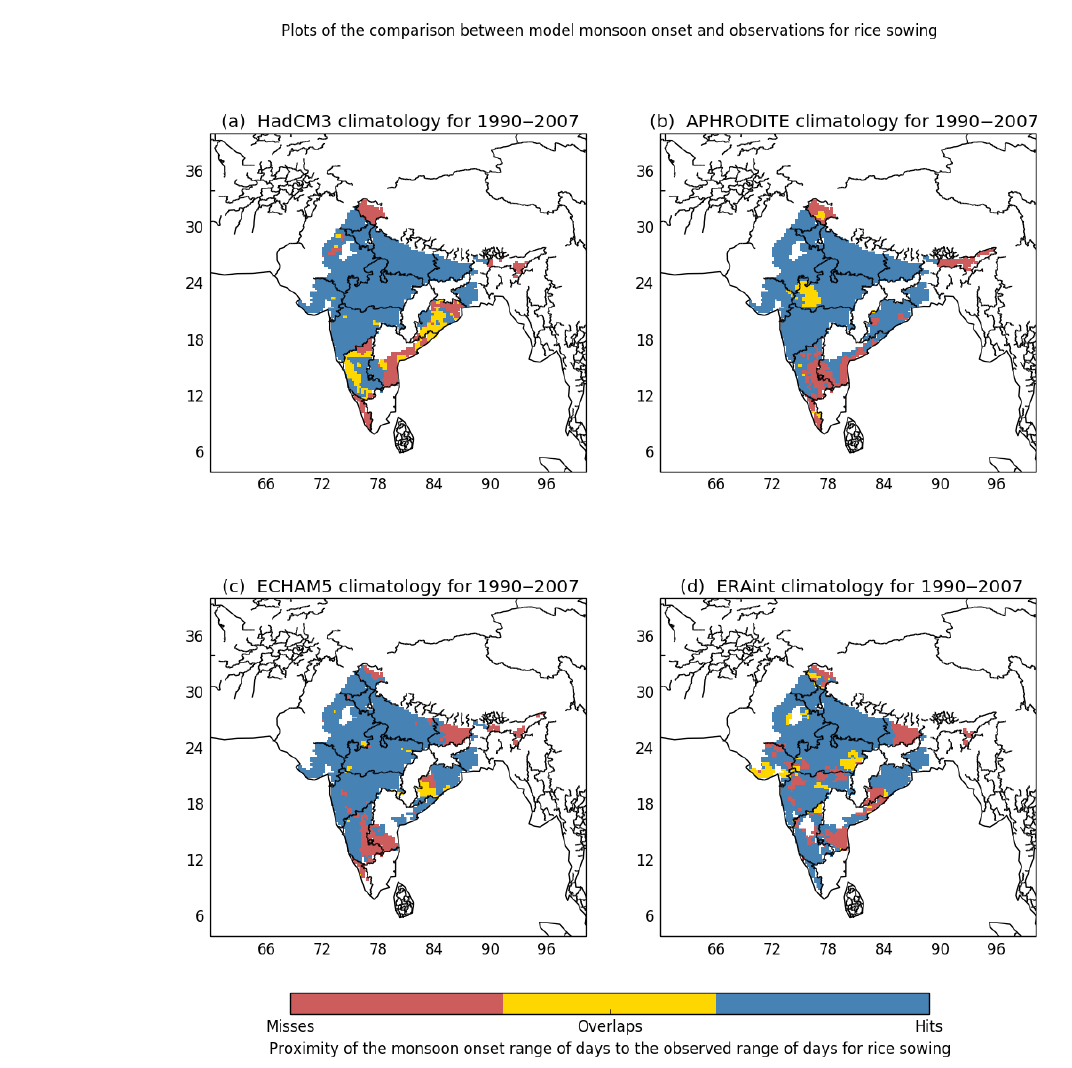
Figure 6. The comparison of the model monsoon onset in terms of the days of the year (to within the pentad) and the range of days of the year for the observed sowing date for rice. This is shown in terms of hit (blue) and overlap (yellow); if there was no overlap this is shown as a miss